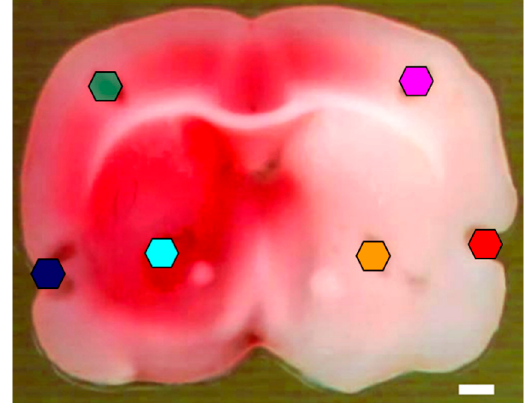
Figure 1. TTC stain of a coronal rat brain section after tissue puncture. The normal brain area at the left hemisphere was stained in red, whereas the ischemic brain area was stained in white. Punctured areas were color-marked in hexagons: blue: normal temporal cortex (N-TCX); green: normal parietal cortex (N-PCX); light blue: normal striatum (N-ST); red: ischemic temporal cortex (I-TCX); pink: ischemic parietal cortex (I-PCX); orange: ischemic striatum (I-ST). Color codings of the specific brain regions in this figure are used throughout. Bar = 1 mm.